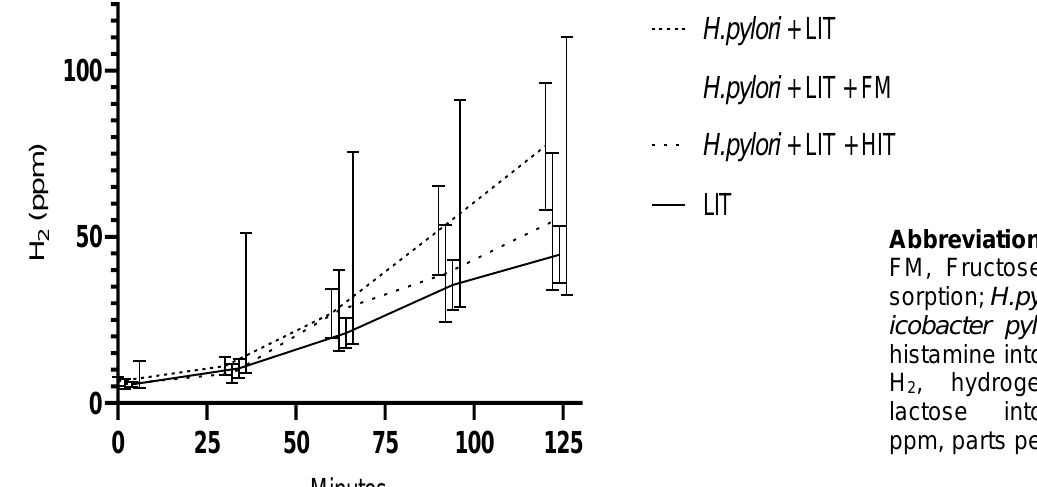
Figure 1: Medians and 95 % confidence intervals of rising H 2 in parts per million (ppm) during lactose breath tests in 433 LIT patients with >20 ppm increase of expiratory H 2 from baseline. Included are 153 LIT-only patients without H. pylori infection. Of 280 H. pylori infected LIT patients 58 were with additional LIT only, 46 H. pylori patients with LIT and HIT, and 23 H. pylori patients with LIT and